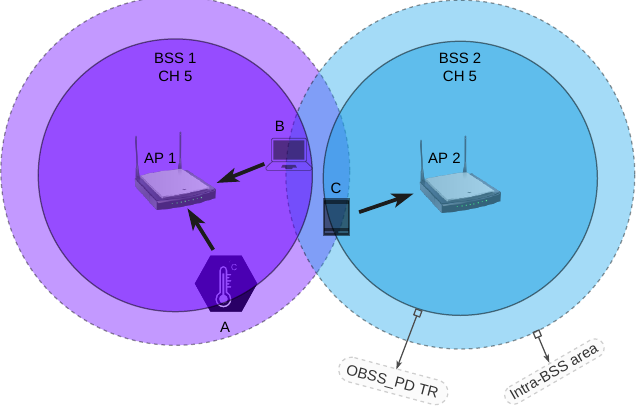
Figure 12. Two overlapping BSSs: the smartphone and the laptop are in the hearing range of both access